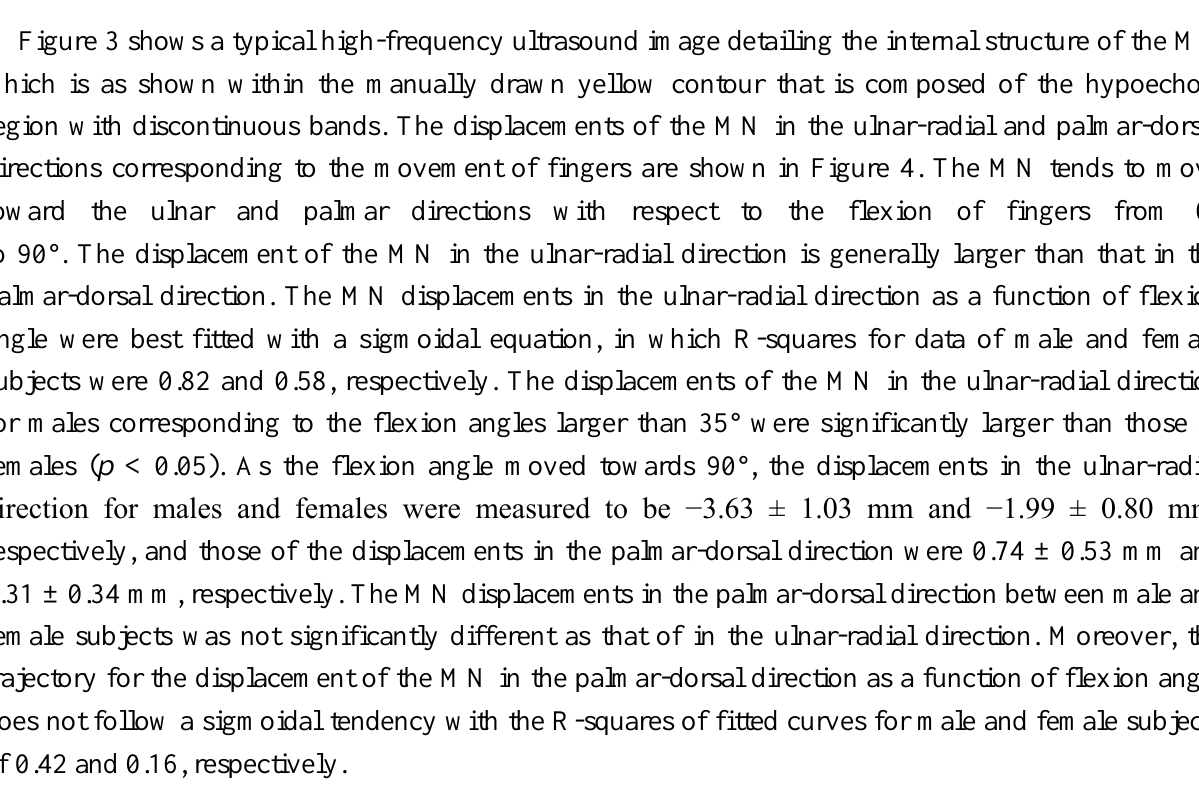
Figure 4. Displacements of the MN in the ( a ) ulnar-radial direction and ( b ) dorsal-palmar direction for males and females while flexing fingers from 0° to